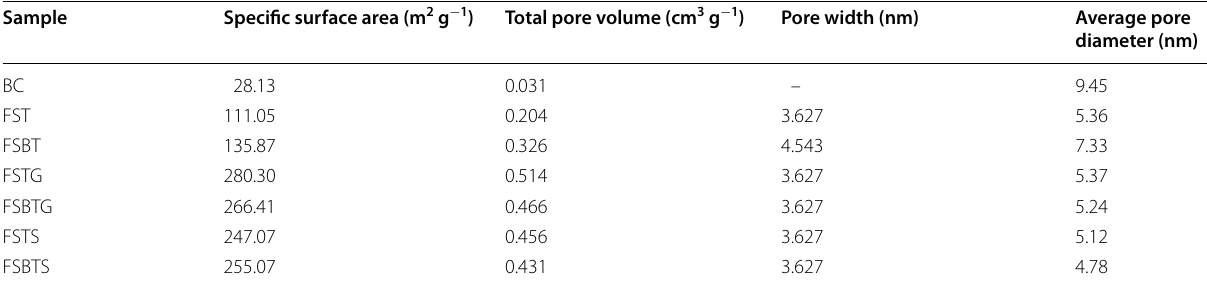
Table 1 The main surface characteristics of biochar and as-synthesized catalysts Sample